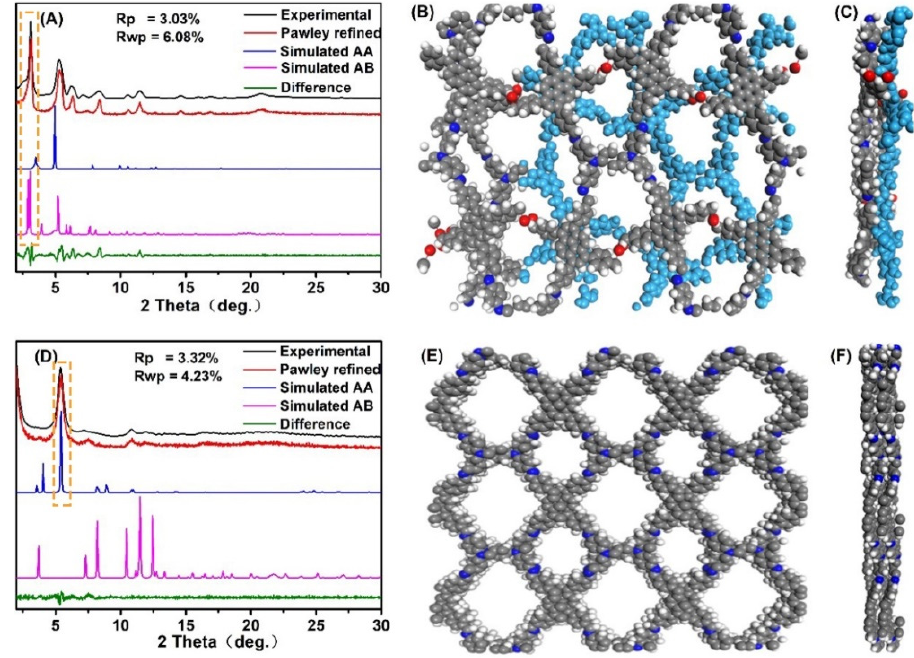
Figure 2. Experimental, simulated, and Pawley-refined PXRD of the PyT-1 crystal structure on the basis of the AB slipped stacking forms ( A ), top view ( B ) and side view ( C ) of the slipped AB stacking form of PyT-1 based on PXRD and modeling; experimental, simulated, and Pawley-refined PXRD of the PyT-2 crystal structure on the basis of the AA slipped stacking forms ( D ), top view ( E ), and side view ( F ) of the slipped AA stacking form of PyT-2 based on PXRD and modeling.